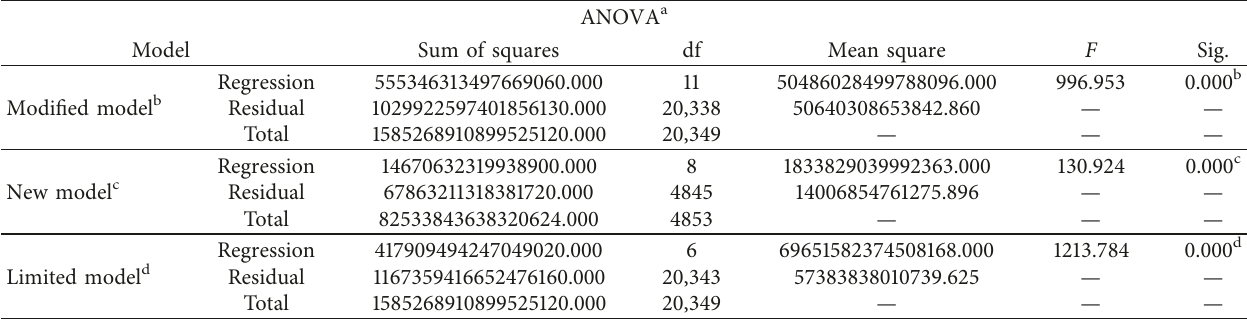
Table 7: ANOVA for a DOE small office building depending on different models.